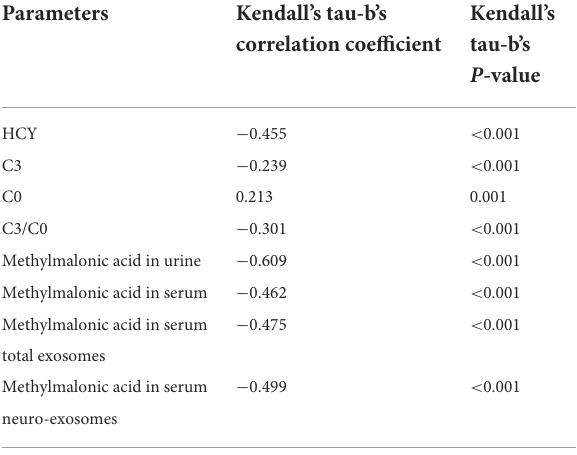
TABLE 3 Correlation between DQ or IQ scores and the metabolites biomarkers.